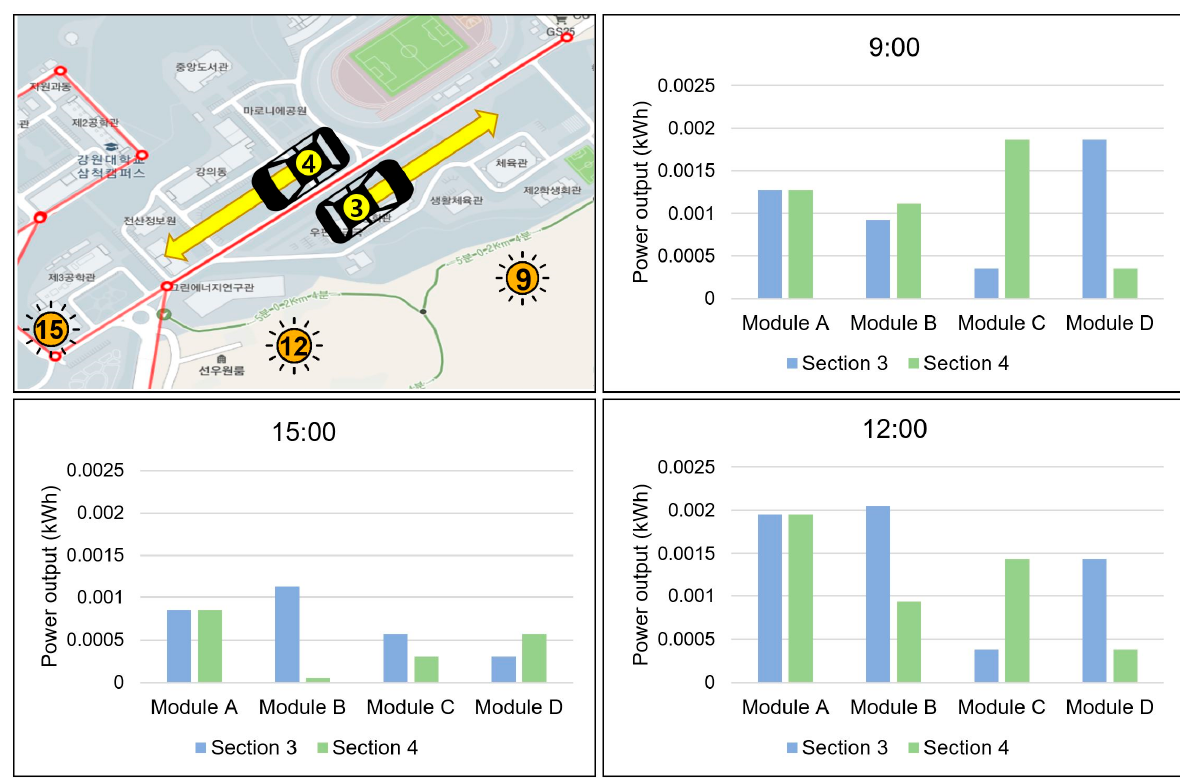
Figure 9. Comparison of PV potentials of four modules by time in section 3 and section 4 in opposite azimuth (Korean labels in the map indicate the building